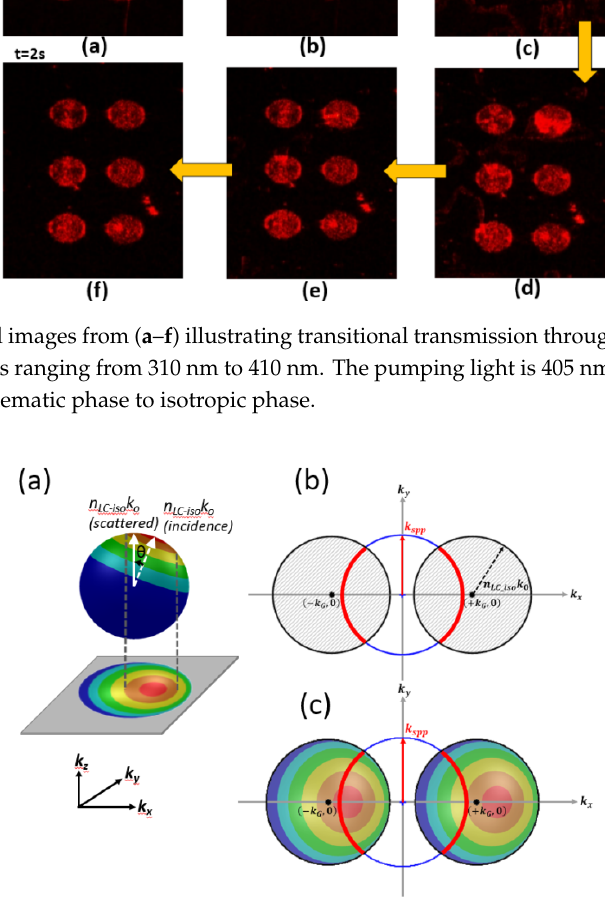
0.071 Figure 8 represents the scattering event modulated by circular gratings. The Mie scattering-filled circle area could move around the dotted circular outline that represents the k G vector of the circular grating. In the meantime, the red highlighted k spp circle could intersect with the Mie scattering color area, which represents the Mie scattering k vectors modulated by the circular grating k G vector could meet the excitation criterion for surface plasmon polariton. It is worth noting that k G vector length could be in a wide range due to different grating pitches, while the color circle area scanned around the dotted line (with radius k G ) could excite the plasmonic modes. The interaction time much shorter on circular gratings than the stripe ones shown in Figures 3, 5, and 6 might be the following: Firstly, the cell gaps of stripe gratings and circular ones are 8 and 6 microns, respectively. The thickness of LC layer might affect the transition time slot. Secondly, there are higher chances for the scattering components matching k spp by adding up k G with 360° span from circular gratings. Thirdly, the original alignment of stripe grating substrate and circular one are different. The circular one somehow favors the boundary turning on process. The short interaction time on circular gratings actually indicates that this scheme is more suitable for sensor applications since it is more effective in time and more sensible for the refractive index change on the surface.